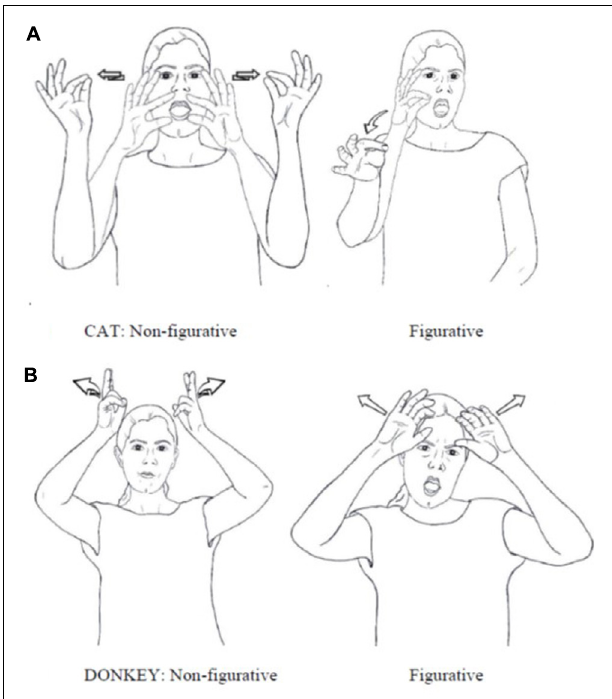
FIGURE 6 | Differences in form between figurative and non-figurative use of ISL signs: (A) CAT. (B) DONKEY.